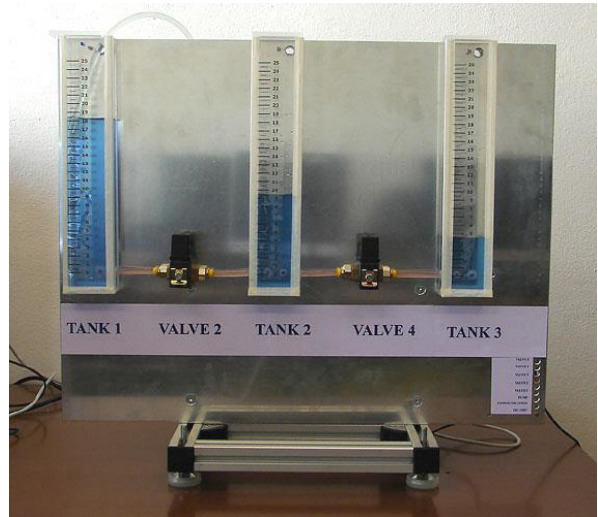
Figure 19. Hydraulic laboratory setup.